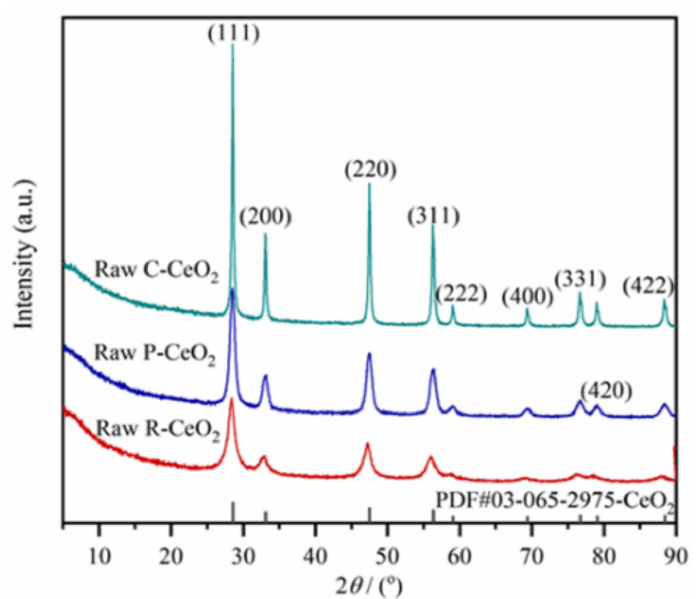
Figure 1. XRD patterns of raw P-CeO 2 , C-CeO 2 and R-CeO